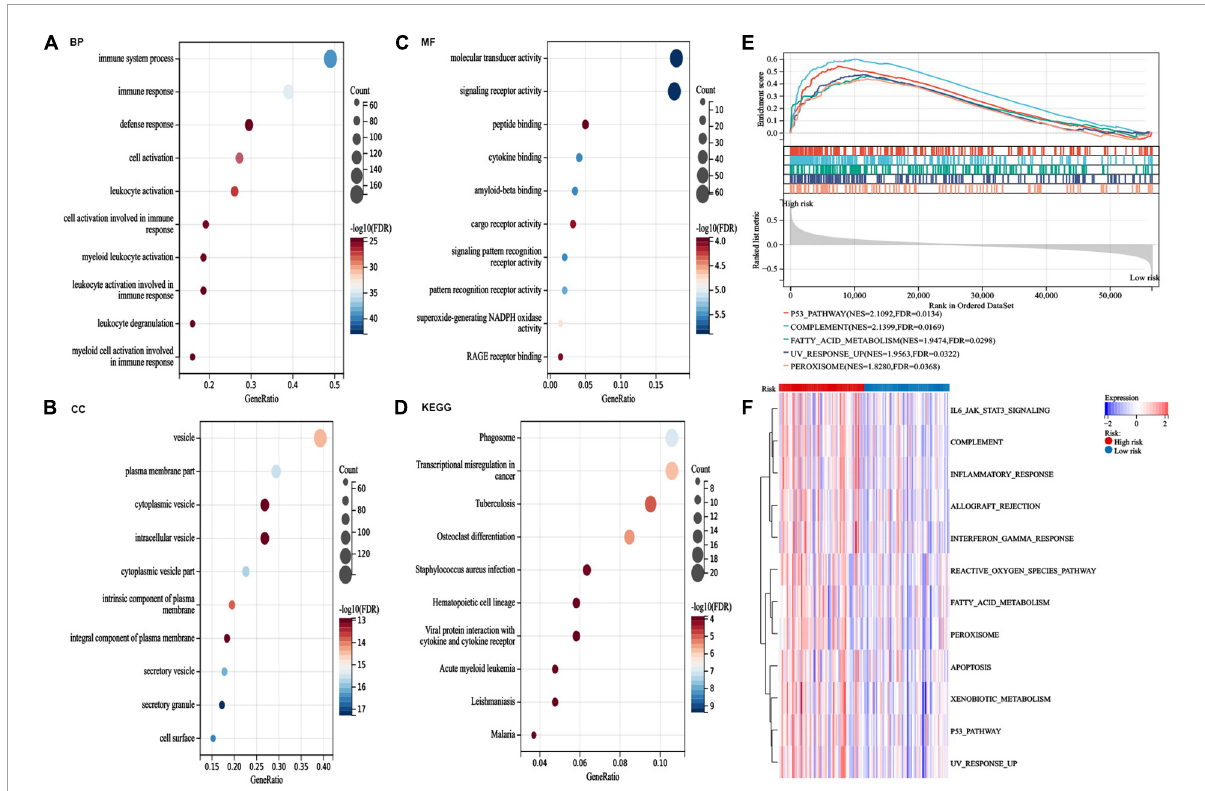
FIGURE7 Pathway enrichment analysis between risk groups. (A–C) gene ontology (GO) analysis for differentially expressed genes (DEGs) between the two risk groups. (D) kyoto encyclopedia of genes and genomes (KEGG) pathway analysis for DEGs between the two risk groups. (E) The top five activated hallmark pathways by gene set enrichment analysis (GSEA). (F) Heatmaps of hallmark analysis in the risk groups by gene set variation analysis (GSVA) enrichment